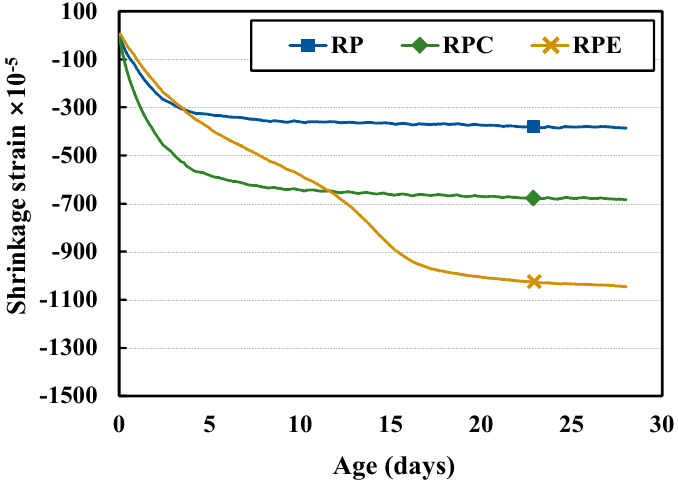
Figure 4. Shrinkage results for the red clay binder specimens.